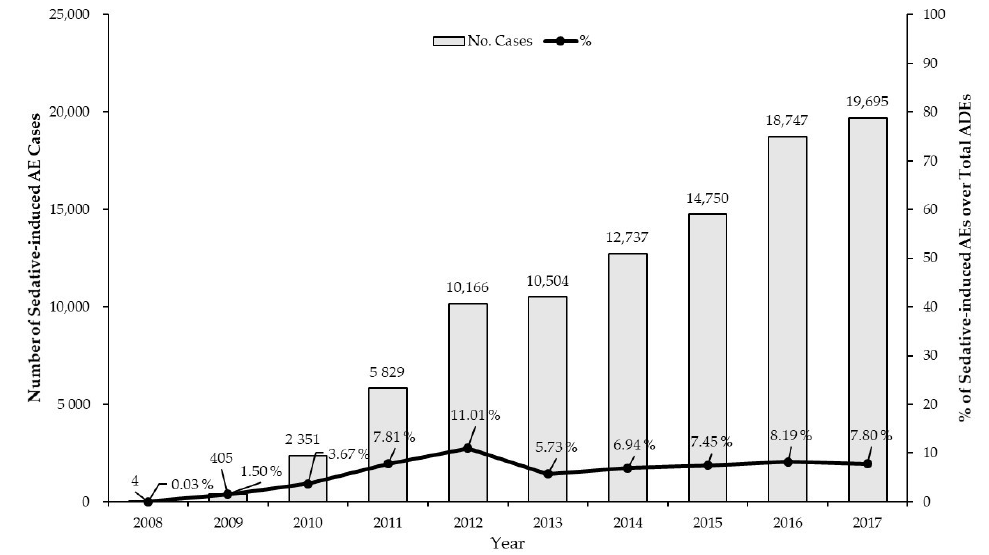
Figure 1. The number and rate of sedative-induced adverse events (AEs) reported from 2008 to 2017 (ADEs, adverse drug events). Table 1. Sedatives implicated in certain, probable/likely, and possible adverse event (AE) cases (re-